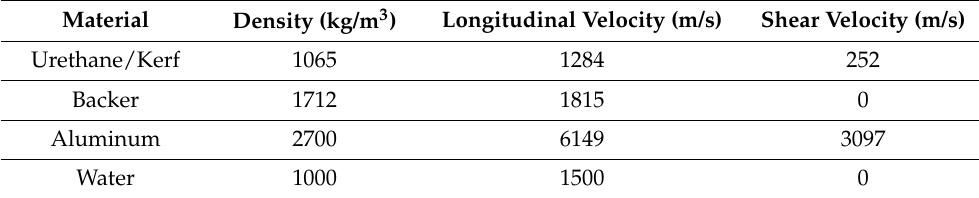
Table 5. Material properties of constituent components of the conformal array.